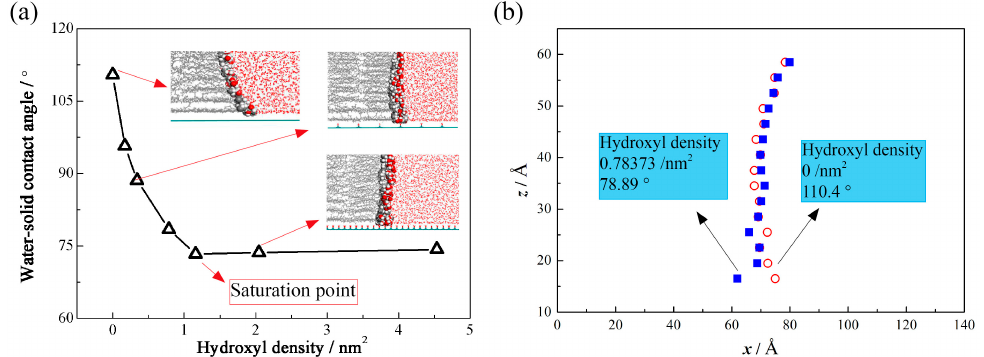
Figure 2. Effect of hydroxyl density on water-solid contact angle. ( a ) Contact angle for graphite system and hydroxylated system with different hydroxyl density ( b ) Oil-water interface points obtained by calculating the water interface and oil interface separately adopting the density method.